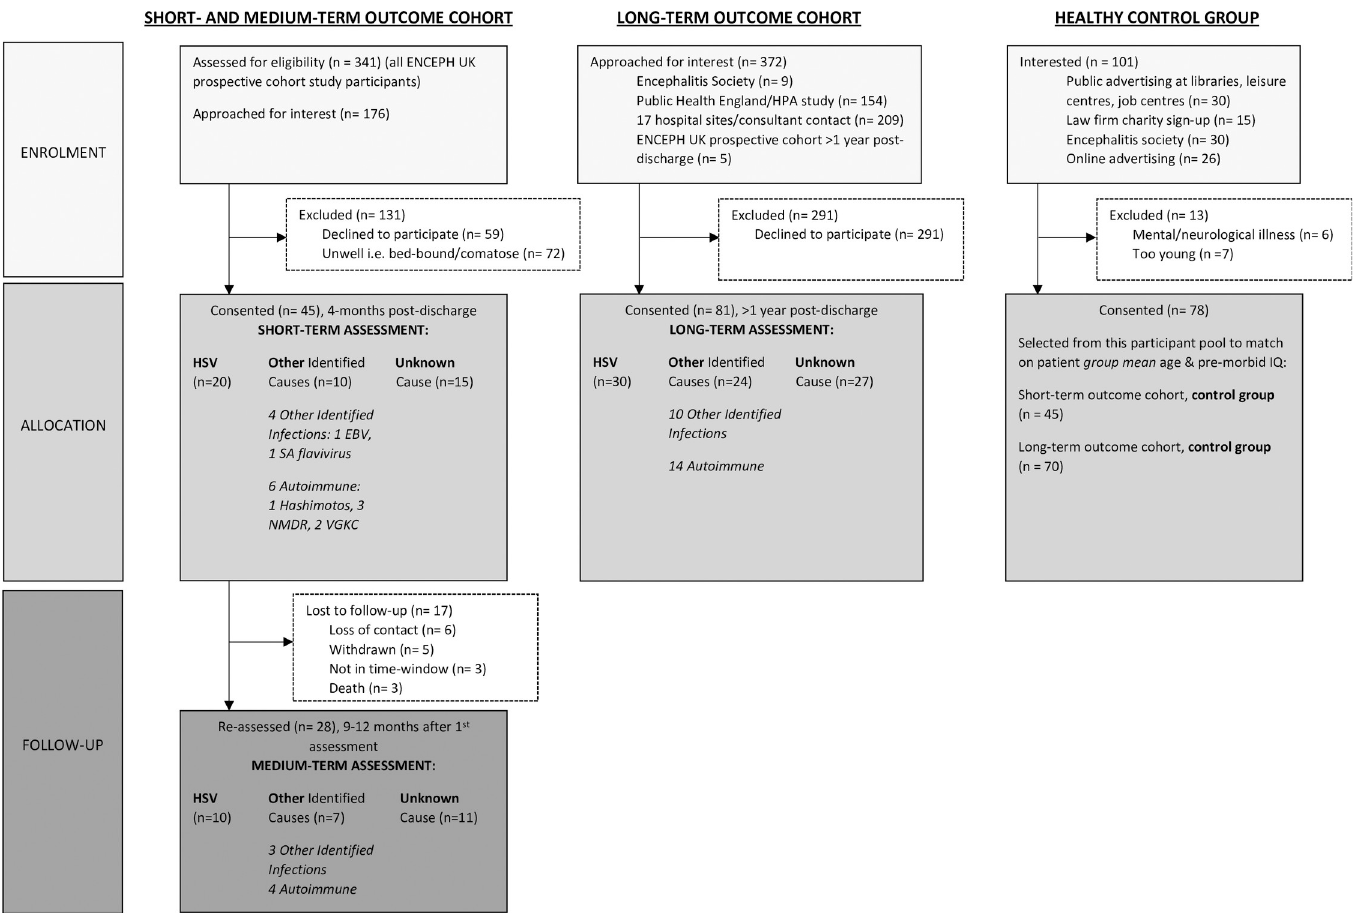
Fig 1. Flowchart to outline the details of the recruitment process of patients with encephalitis into the short- and medium-term and long-term outcome cohorts, and of healthy controls.